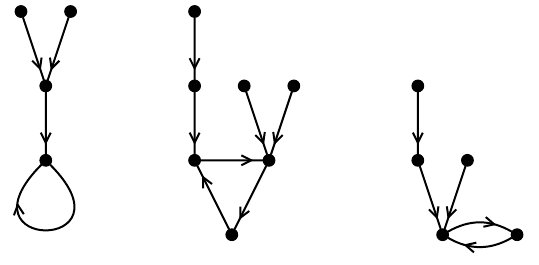
Figure 16: The digraph of a function.